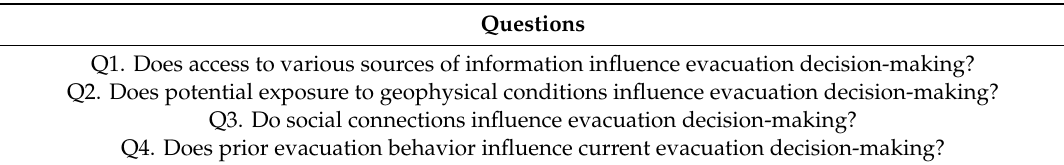
Table 1. List of research questions used in this